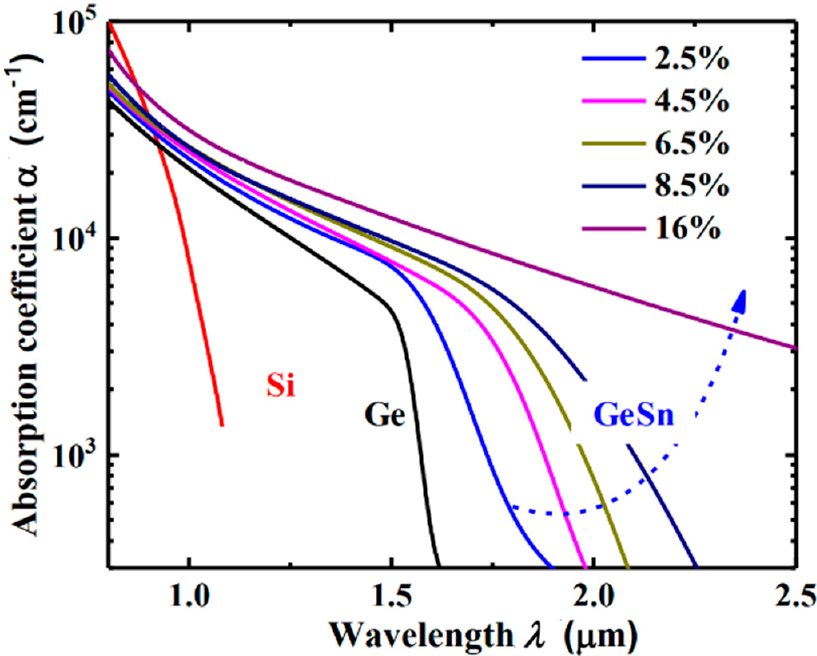
Figure 10. Absorption coefficient of compressive GeSn on Ge with various Sn compositions ranging from 2.5 % to 16 %. Reproduced from [65], open access by NUS Library, 2019. In the past decade, tremendous efforts had been made on the GeSn photo detection. With a very small incorporation (2%) of Sn into Ge, the absorption coefficient for GeSn